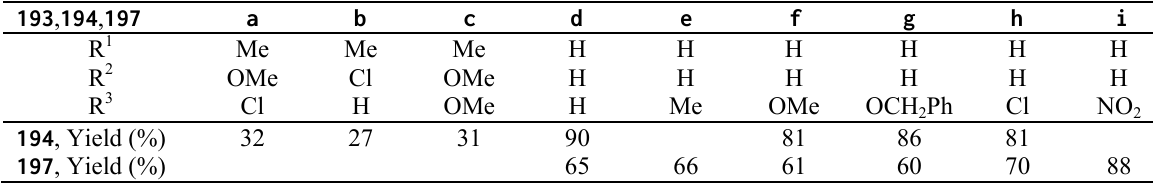
Table 16. Effect of substituents on the yields of phototransformation of 3- arylideneflavanones to 3 α -hydroxybenzylflavones.